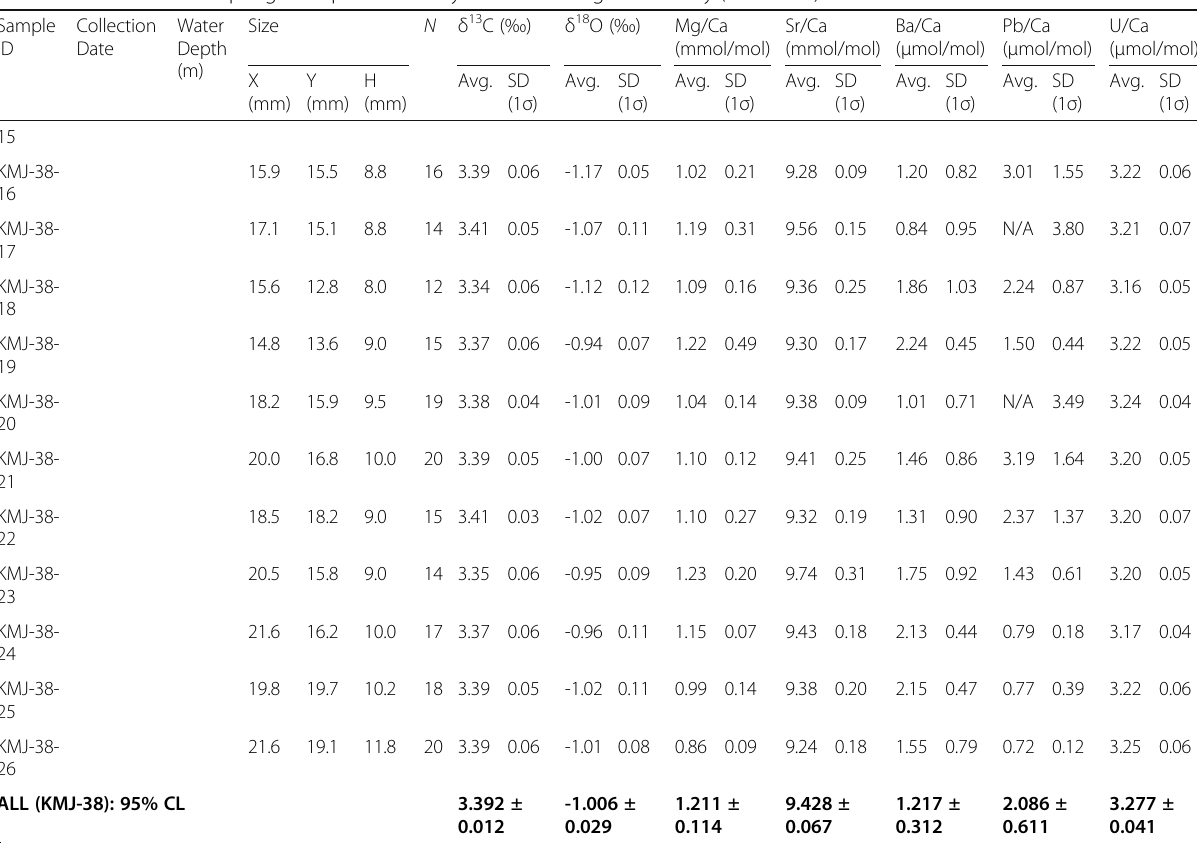
Table 1 Details of sclerosponge samples and analytical results of geochemistry